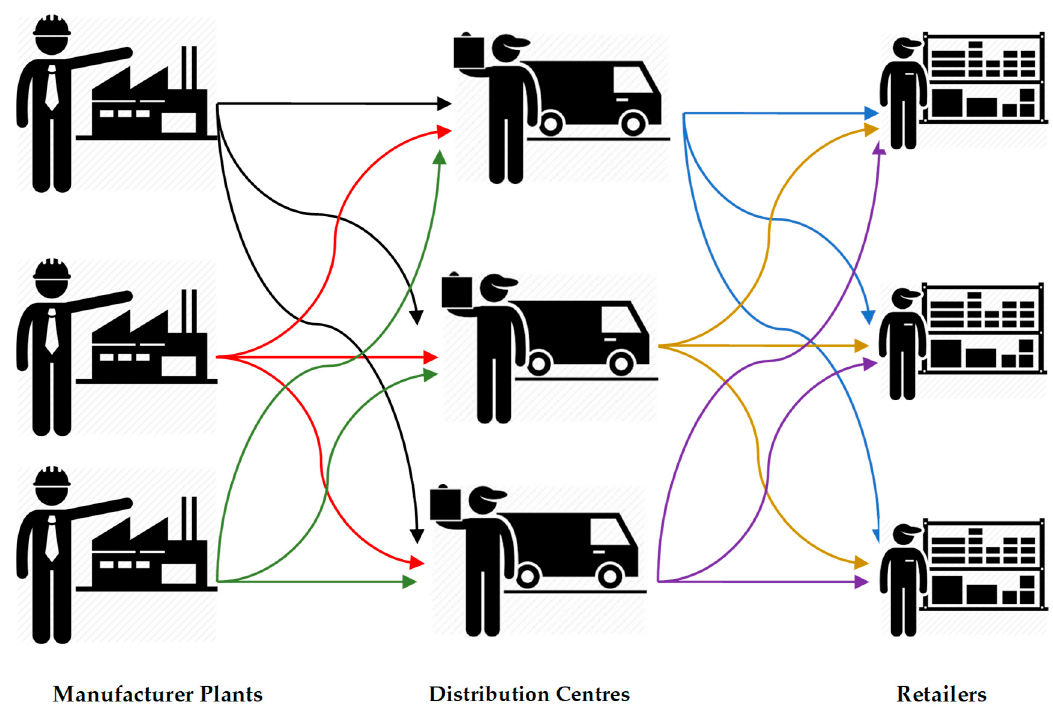
Figure 3. Additional operators in the modified FA.